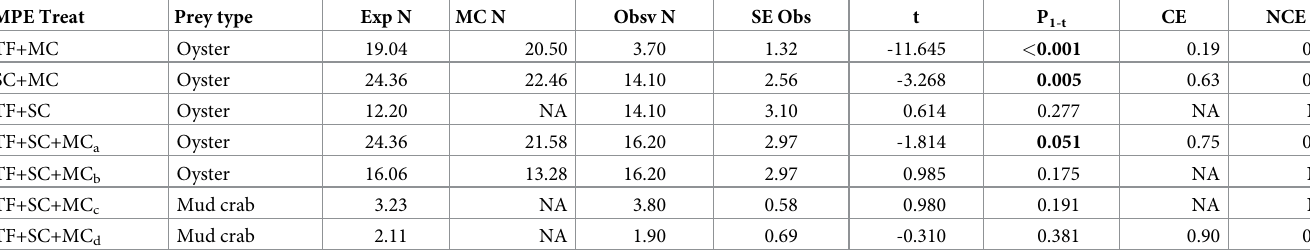
Fig 1. Total number of juvenile oysters consumed across MPE treatments for limestone gravel and oyster shell substrates. MPE treatments: Control = predators not present; SC = stone crab; TF/SC = toadfish and stone crab; MC = mud crab; SC/MC = stone crab and mud crab; TF/MC = toadfish and mud crab; TF/SC/MC = toadfish, stone crab and mud crab. https://doi.org/10.1371/journal.pone.0242965.g001 for both substrates). Accordingly, mud crab feeding was more inhibited by toadfish when it was the only top predator (oyster NCE = 0.81) than when the stone crab was the only top pred- ator (oyster NCE = 0.37). And mud crab feeding was least inhibited in the presence of both top predators (oyster NCE = 0.25) (Table 3). As such, the greatest loss of mud crabs Table 3. Risk-model t-tests for MPE experiment